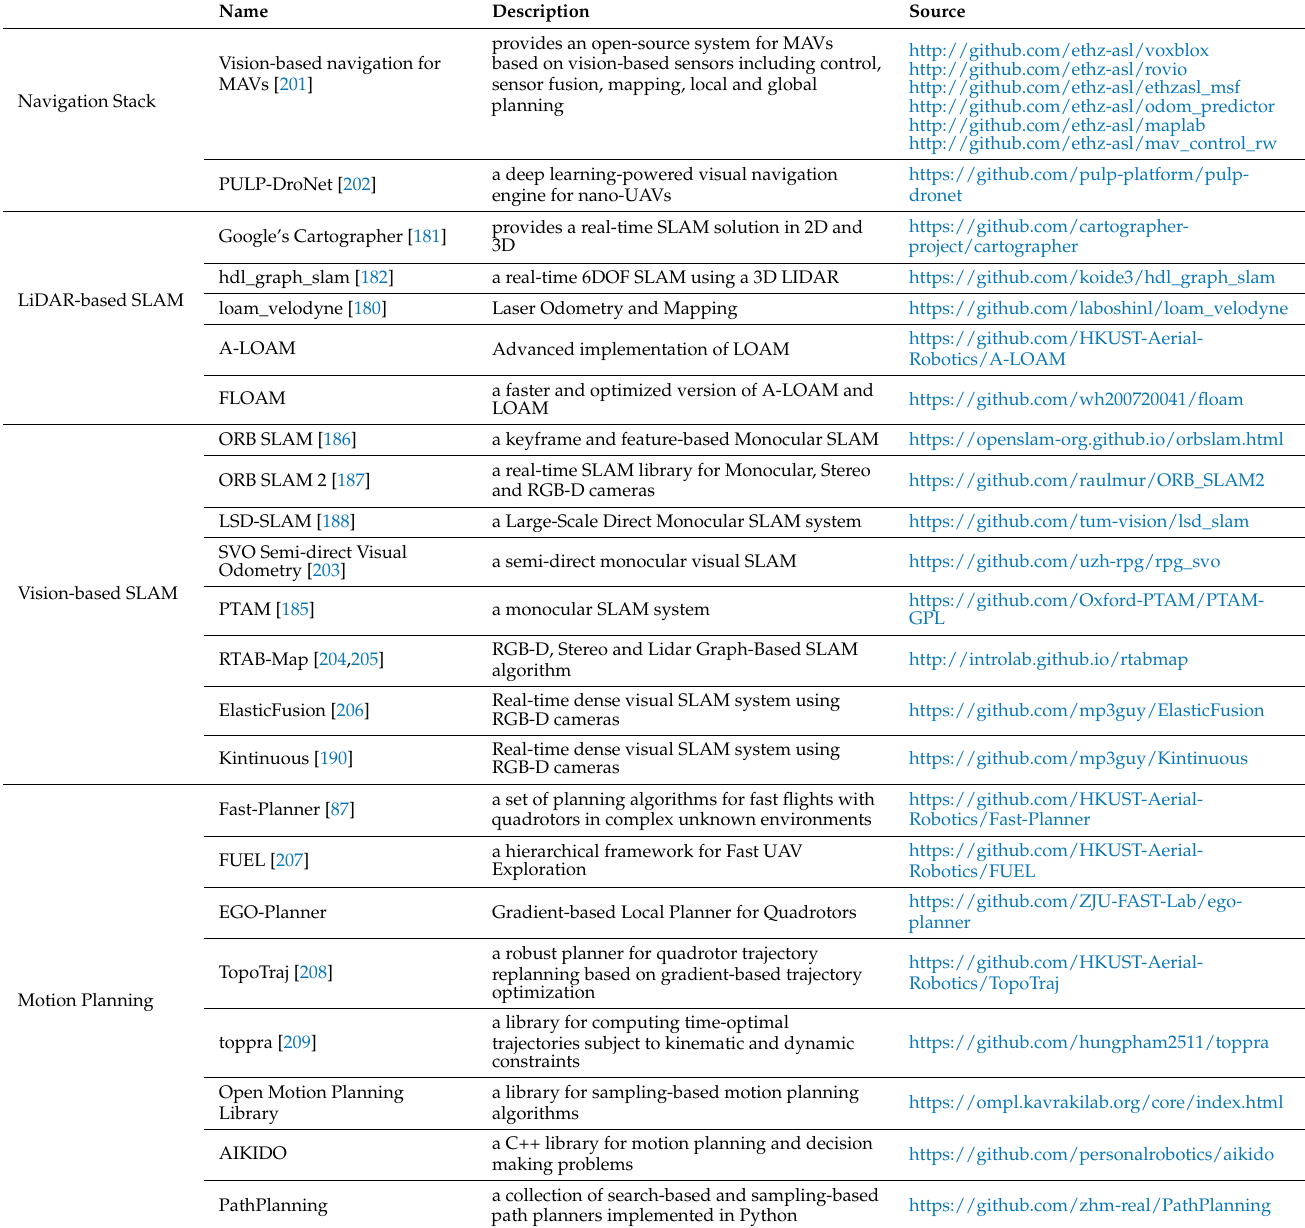
Table 3. Open-source projects and tools for UAV